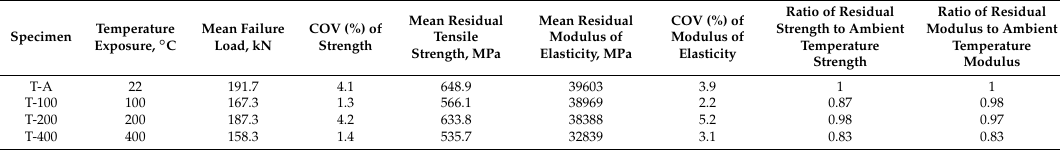
Table 2. Summary of Tensile Test Results.